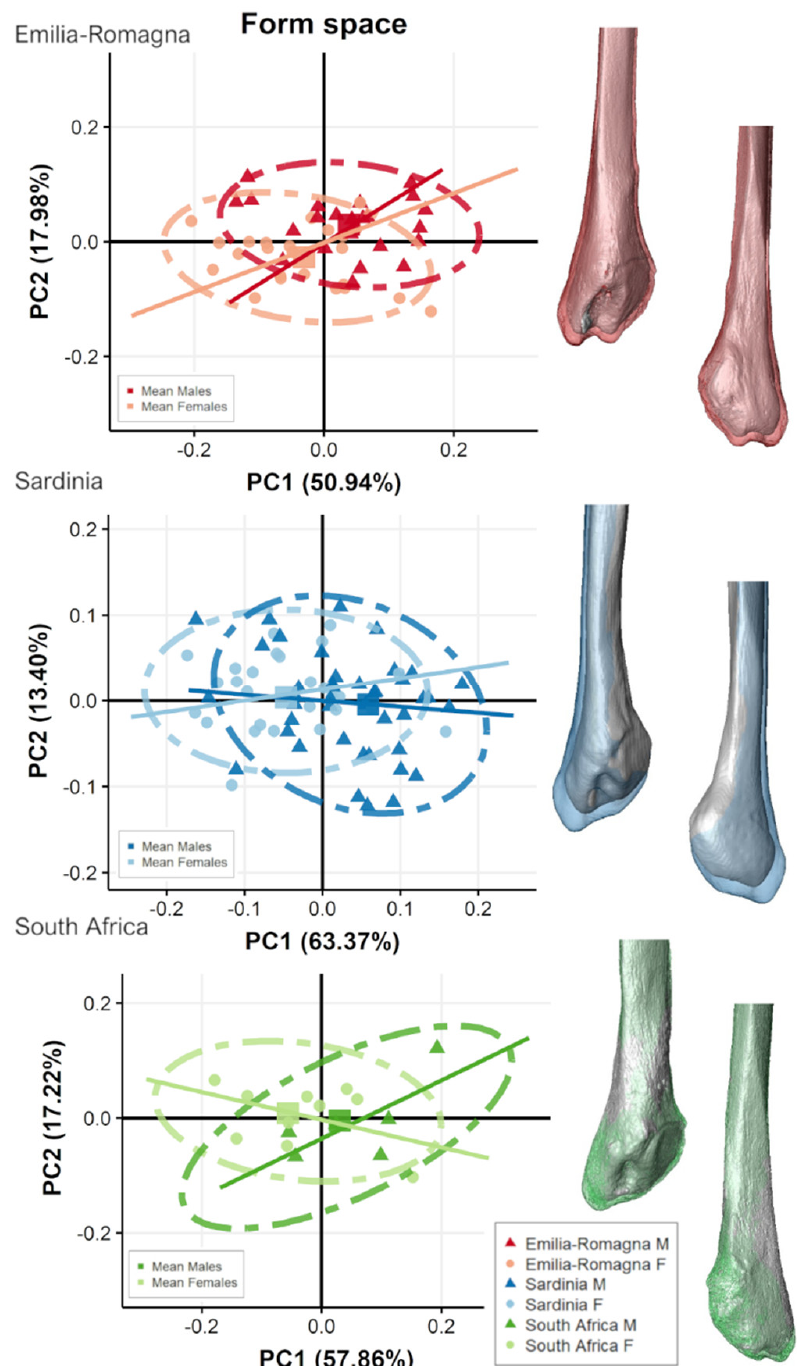
Figure 8. Scatterplot of form-space PC scores of distal fibular epiphyses for the two Italian and the South African populations, divided by sex groups and presenting mean male (colored) and female (grey) form variation along the PC axes, represented in the scatterplot as squared dots, in medial ( top ) and lateral ( bottom ) views. Lines represent allometric trajectories for males and females for each population.